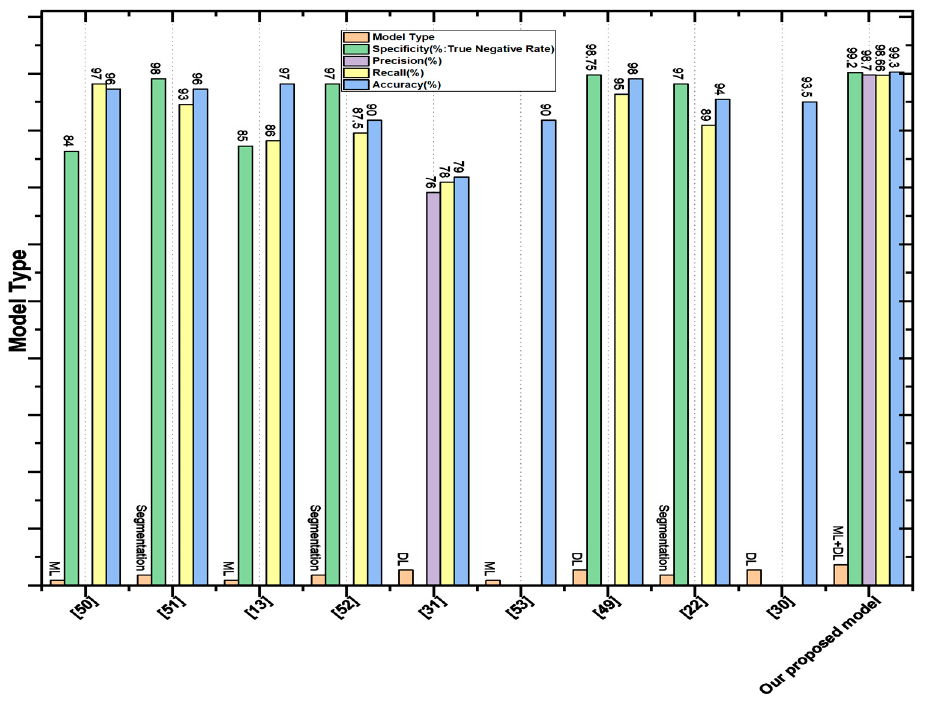
Figure 7. Comparison plot with existing techniques